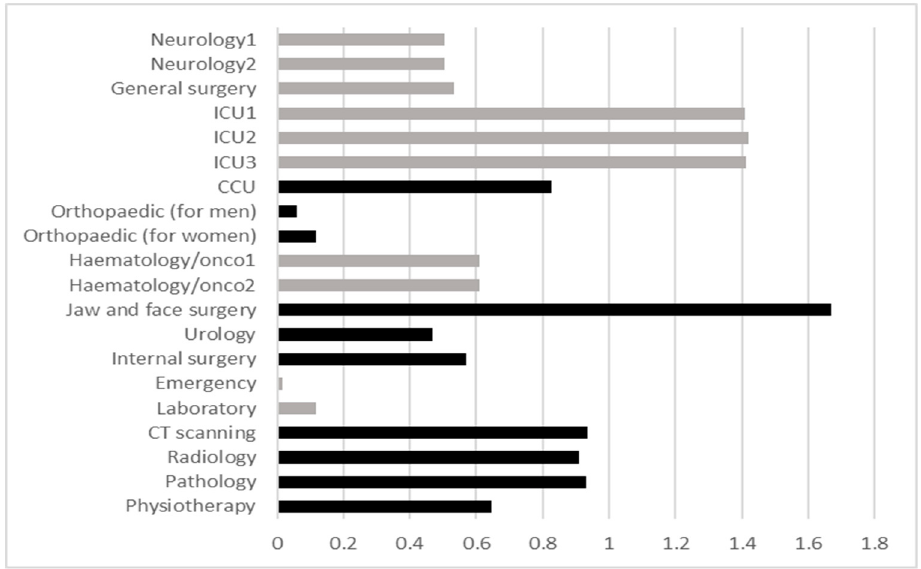
Figure 2. Measurement of infection risk for existing departments of the HF-based DEMATEL result.